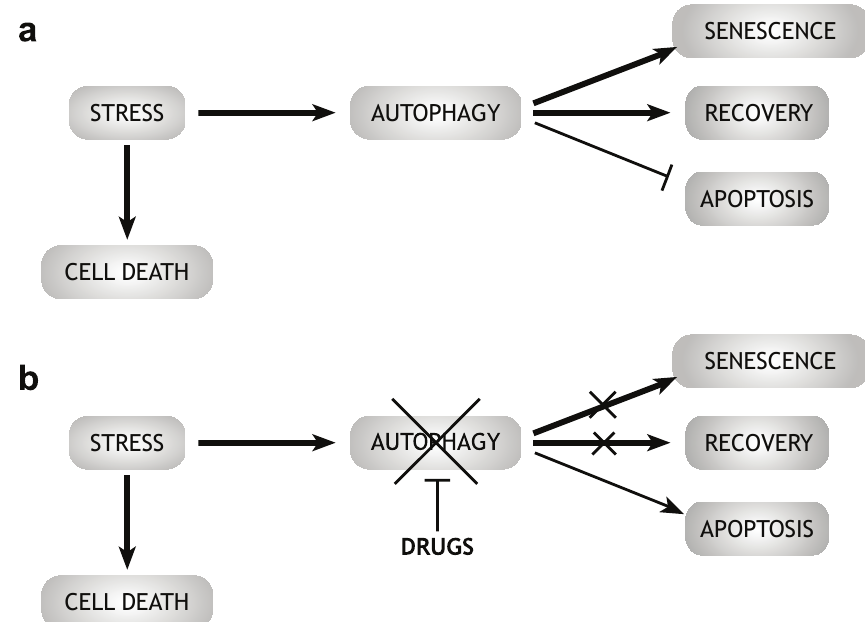
Figure 2 - Interplay among autophagy, apoptosis, and senescence. Effects of a cell stress in control conditions ( a ) or when autophagy is blocked ( b